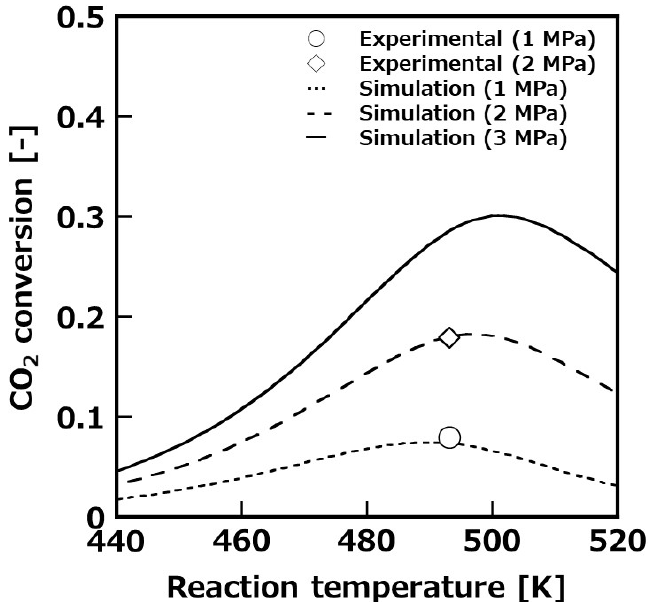
Figure 6. Experimental and simulation results of membrane reactor (SV = 1000 h − 1 ).